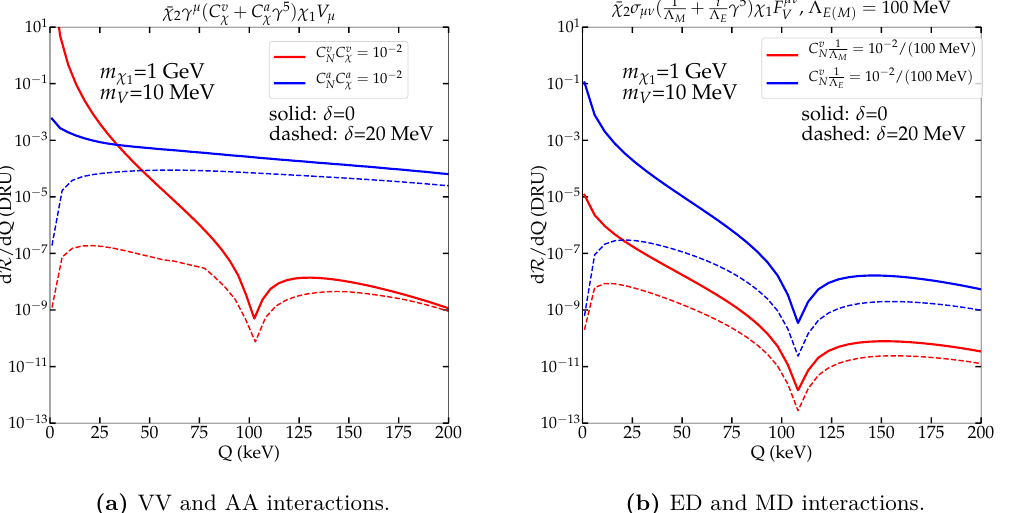
Figure 8. Detection rate d R /dQ (DRU or keV − 1 kg − 1 day − 1 ) of fermionic CRDM χ − xenon scat- tering for L f (left) and L f (right). The mass degenerated cases δ = 0 are represented as solid lines, 1 2 while the dashed lines are for δ = 20 MeV